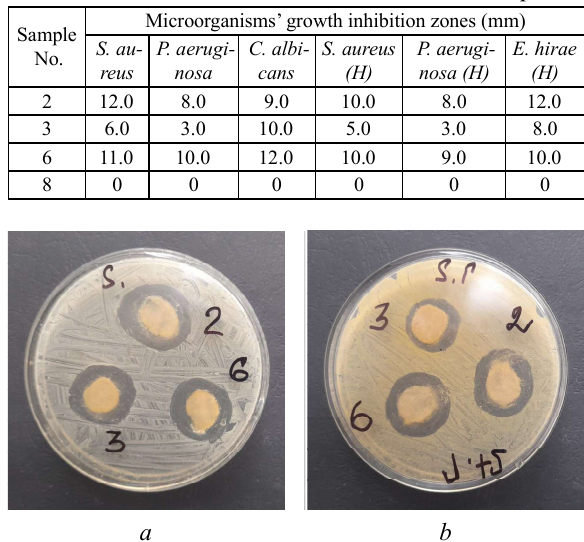
Fig. 3. Growth inhibition zones under the action of “fabric” samples: a – S. aureus ATCC 6583; b – S.